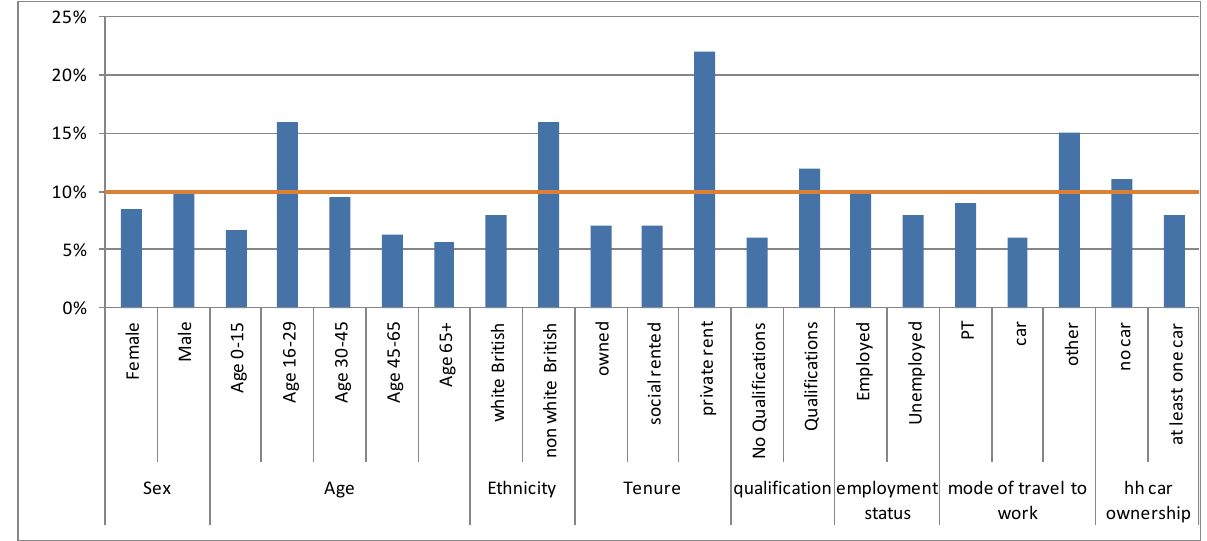
Figure 3. Proportion of the population who can access a bicycle sharing station within a 400m